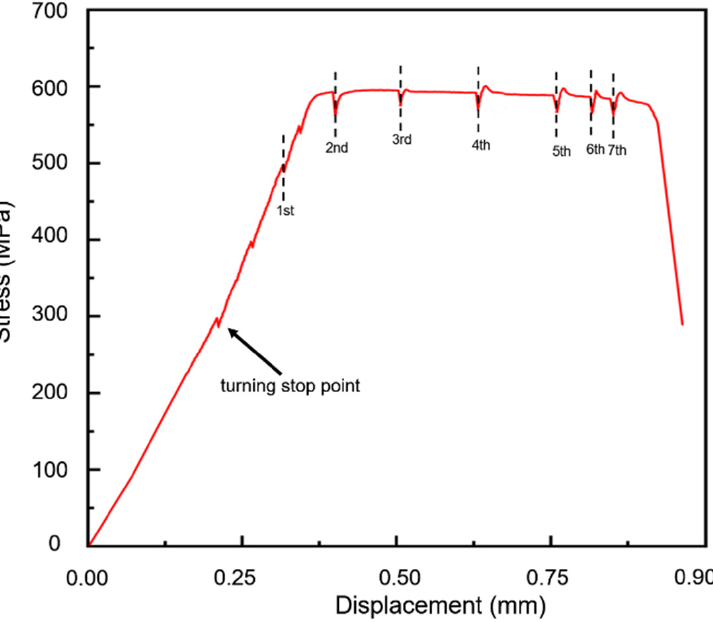
Figure 4. In situ room temperature tensile stress-displacement curve of the solution-treated Ti-22Al- 25Nb alloy.